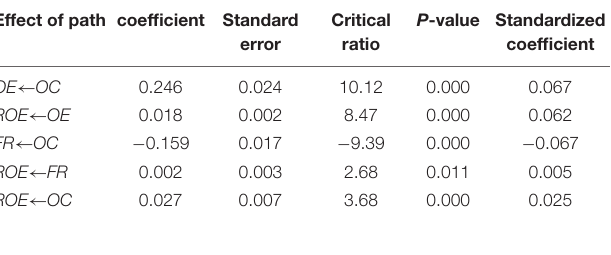
TABLE 12 | Path decomposition of the equity trend of the largest shareholder affecting corporate performance. Equity adjustment